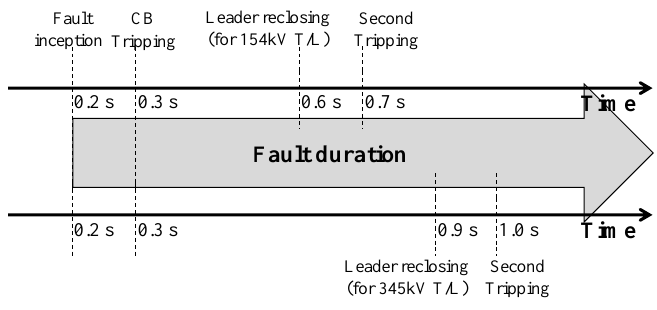
Figure 4. Circuit-breaker operation sequence.